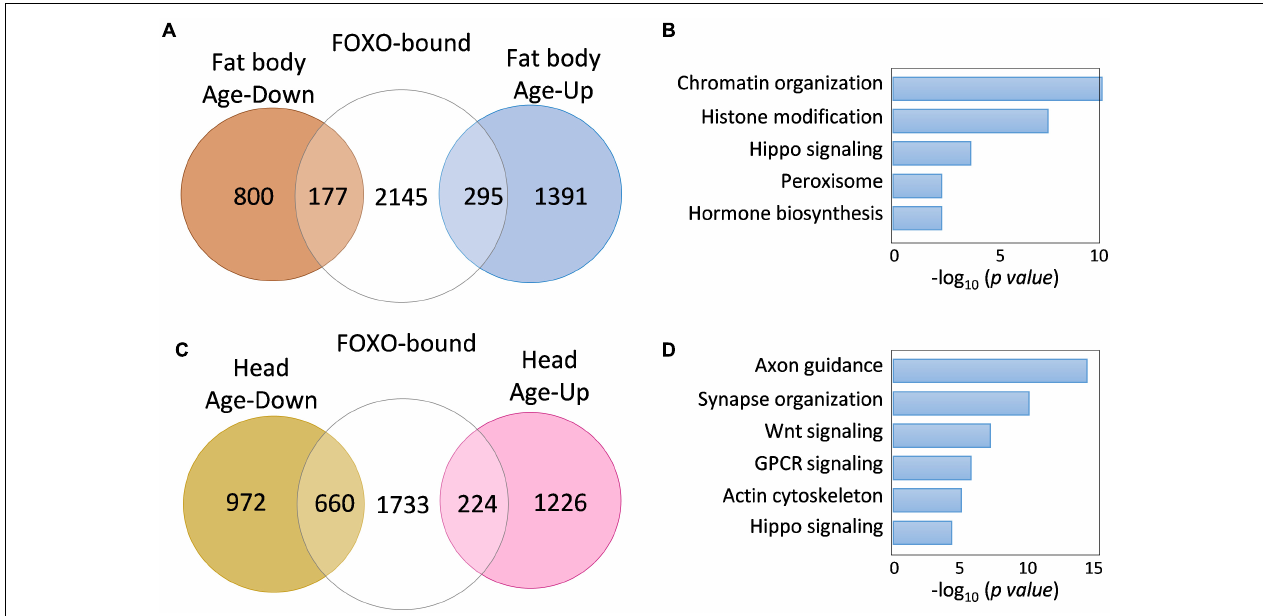
FIGURE 3 | FOXO target genes show age-dependent transcriptional changes. (A) The number of FOXO-bound genes that are differentially expressed in aging fat body. (B) Representative biological processes enriched for age-regulated FOXO targets in fat body. (C) The number of FOXO-bound genes that are differentially expressed in aging head tissue. (D) Representative biological processes enriched for age-regulated FOXO targets in adult head tissue.